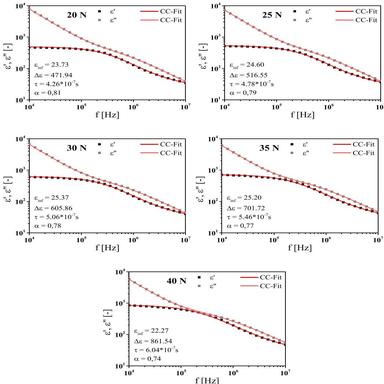
Cole-Cole fits of the real and imaginary parts of the complex permittivity ε\ = ε ′ − i⋅ε′′ under different static loadings as indicated. Fitting parameters are in the inset.